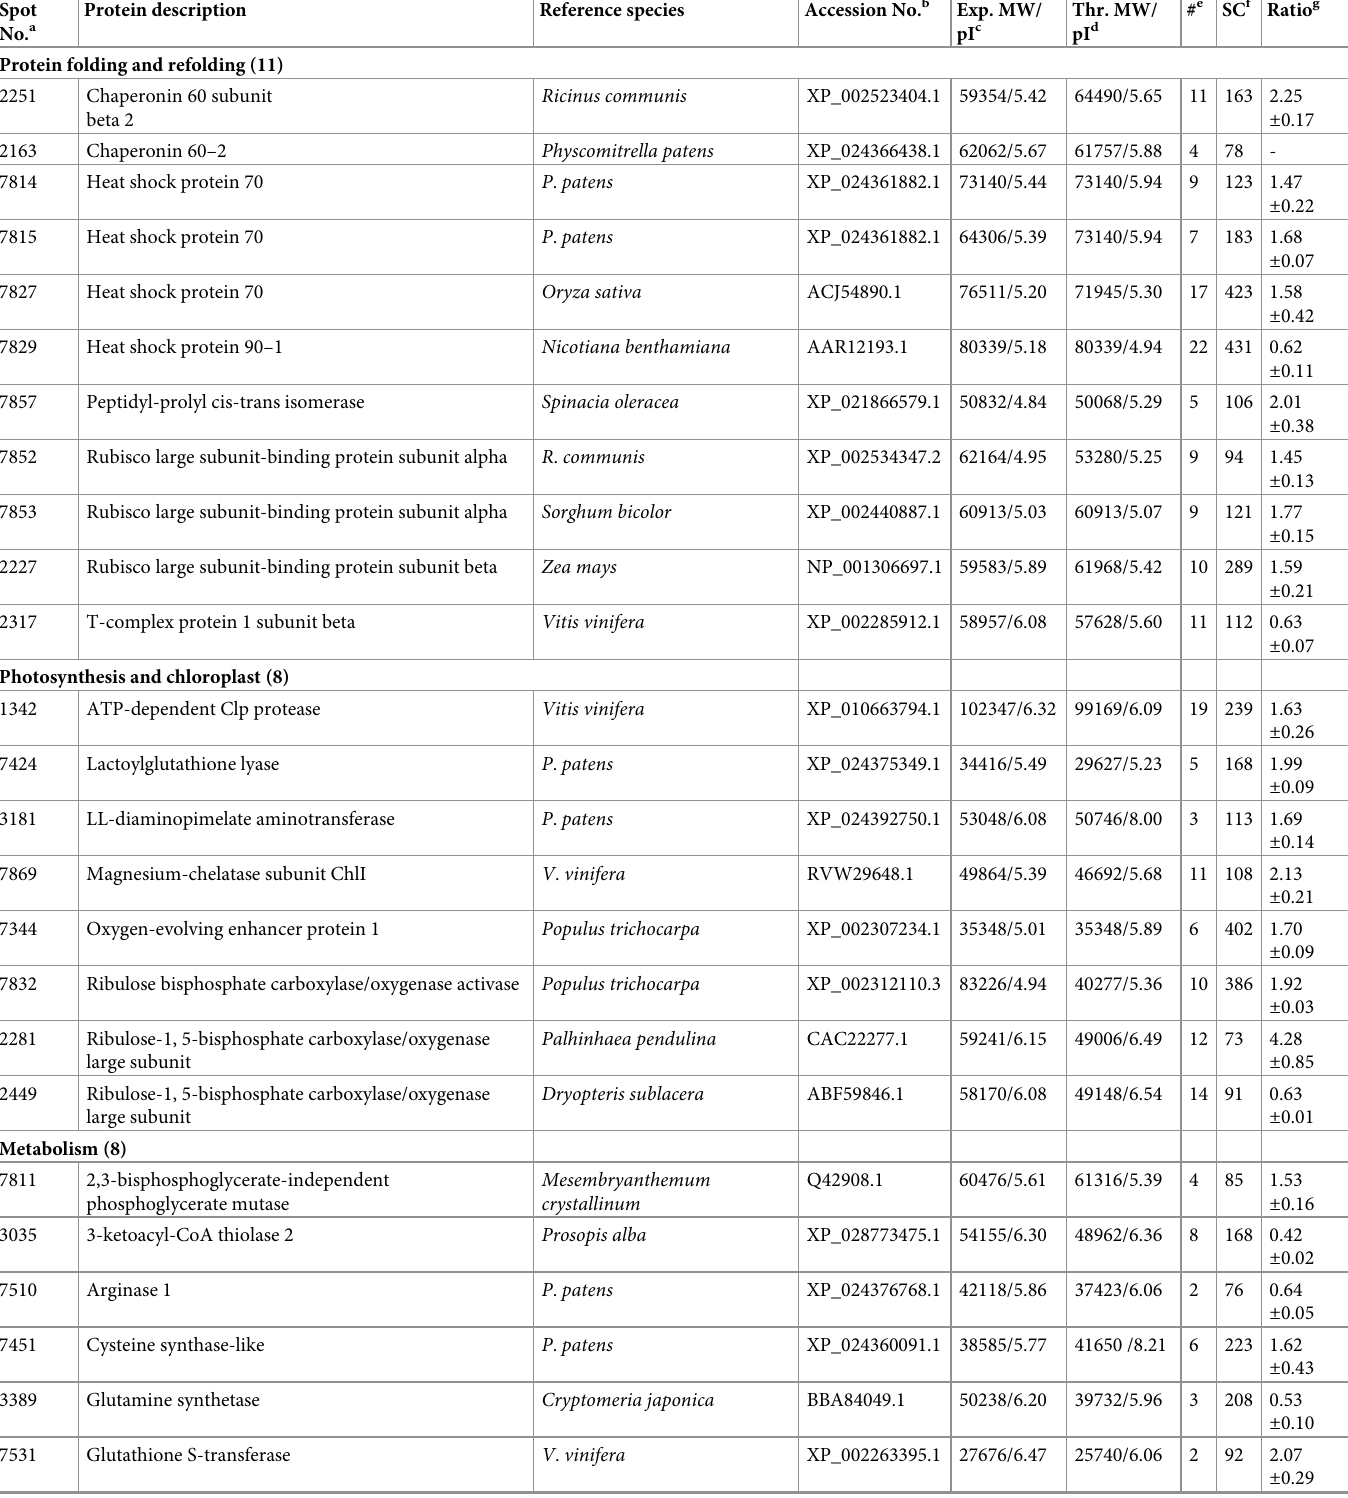
Table 1. Differentially abundant proteins in hermaphroditic and male gametophytes from C . thalictroides . Spot No.